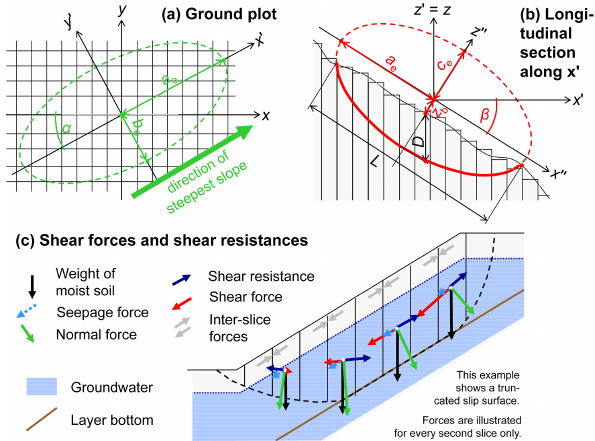
Figure 1. Typical ellipsoid used as slip surface in r.slope.stability: (a) ground plot, (b) longitudinal section, (c) forces acting at each column. The factor of safety is computed for the ellipsoid bottom and (as shown in the figure) for the combination of the ellipsoid bot- tom and each intersecting layer bottom. The geotechnical, hydraulic and geometric details are outlined by Mergili et al.